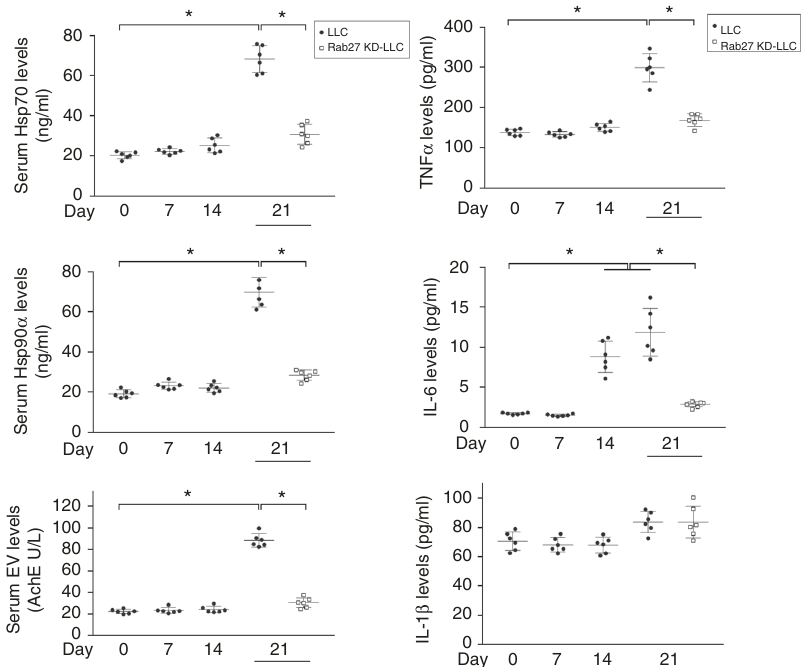
Fig. 10 Tumor-released Hsp70 and Hsp90-expressing EVs mediate systemic increase of in fl ammatory cytokines. Sera from mice bearing LLC tumor with or without knockdown of Rab27 on days 0, 7, 14 and 21 of tumor cell implant were analyzed for levels of Hsp70, Hsp90 and EVs as described above, and TNF α , IL6 and IL-1 β using Bio-Plex ® Multiplex Immunoassays. For Hsp70/90 measurement sera were treated with Brij98 before ELISA. Data ( n = 6) were analyzed by analysis of variance. * denotes a difference ( P <